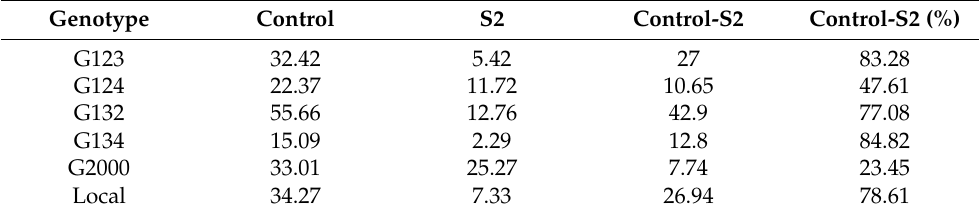
Figure 6. Calculated IC50 for barley root extracts, demonstrating a genotype × treatment interaction ( p = 0.0001). Data points within genotypes and treatments that have the same letter are not significantly different at a 95% level of confidence. Table 1. Percentage of decrease in calculated IC50 for barley root extract value between control and salt treatment (S2) of each genotype.